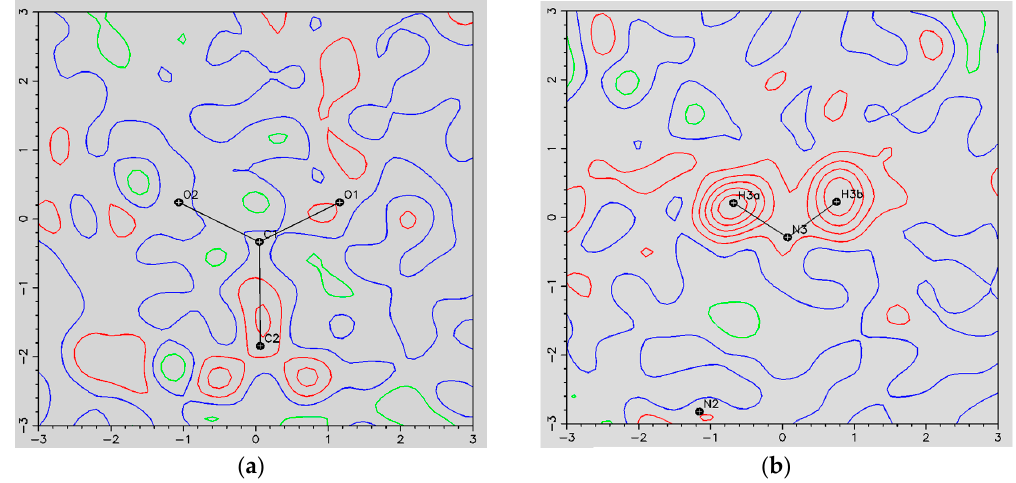
Figure 3. Residual density maps through the deprotonated (carboxylate) ( a ) and protonated (piperazine) ( b ) moieties from ORBI hemihydrate form, obtained by difference Fourier synthesis. Red, green and blue lines show positive, negative, and zero contours levels, respectively. Contour levels correspond to 0.1 e ∙ Å − 3 intervals.